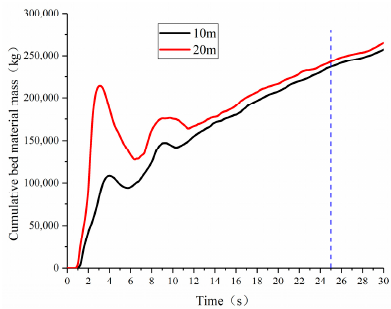
Figure 18. Variation curve of cumulative bed material mass of different sections (0~30 s).